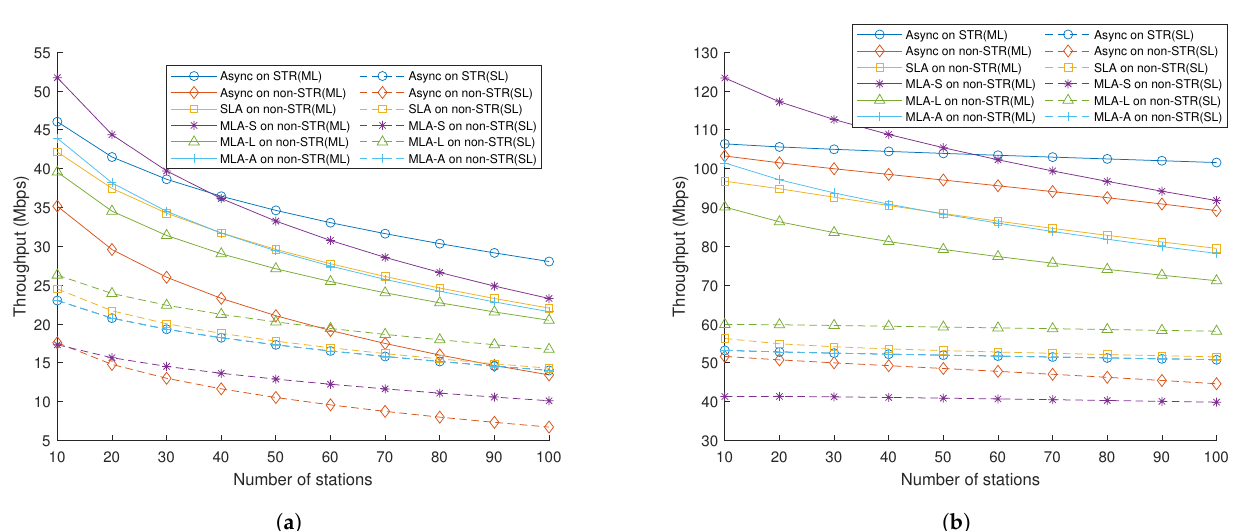
Figure 11. Separated throughput on each MLD and single-link device per a link, ( a ) when RTS/CTS exchange is off, and ( b ) when RTS/CTS exchange is on.